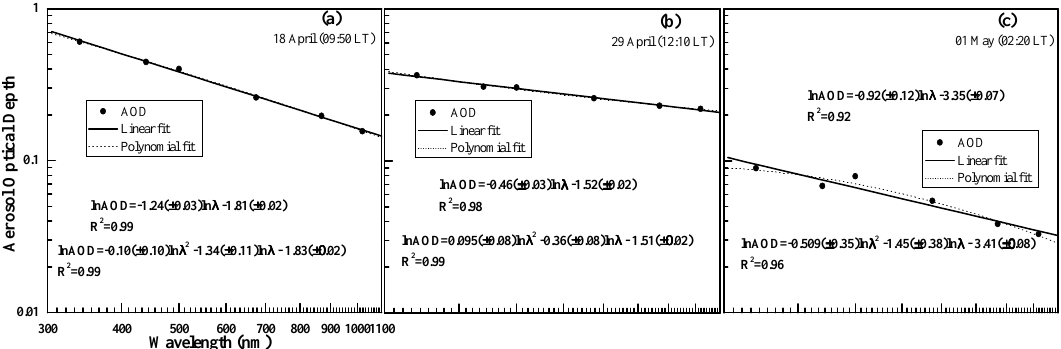
15. Pg 5 right side: If possible replace the Fig 3 with the below Fig 3 : change is with symbols made for better clarity/readability. Current Fig is found even good for black & white printout also.